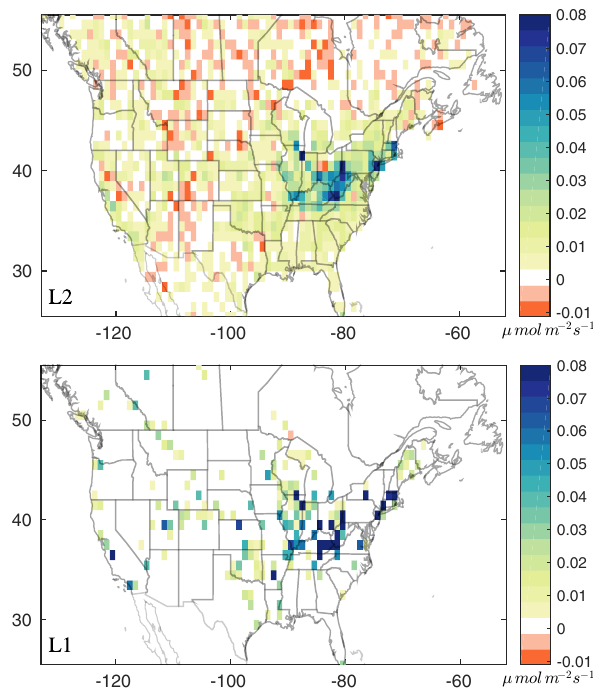
Figure 4. Emission estimates using Tikhonov regularization with the classical 2-norm penalty (see Eq. L2) and the sparsifying 1-norm penalty (see Eq. L1) inverted from noisy simulated methane mea- surements. The true flux field is shown in Fig. 3. While L2 shows the typical smoothing effect, L1 concentrates the signal, which re- sults in better estimates of large sources but also tends to explain regional emissions by larger point